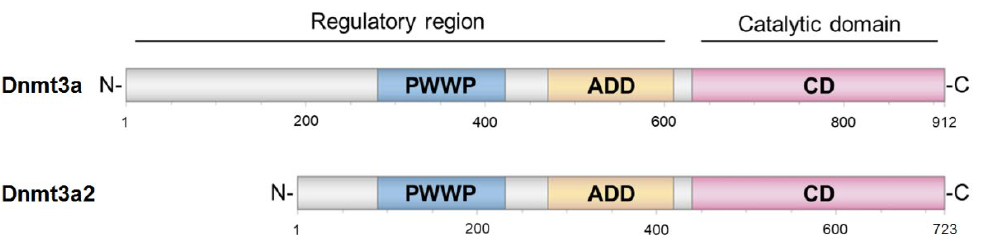
Figure 1. Domain architecture of full-length MTase Dnmt3a and its isoform Dnmt3a2. ADD indicates ATRX-DNMT3-DNMT3L domain; PWWP is Pro-Trp-Trp-Pro domain.